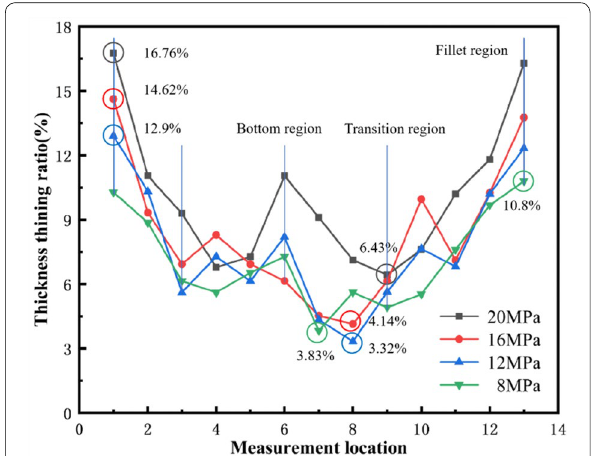
Figure 14 Distribution of thickness thinning ratio under different incident